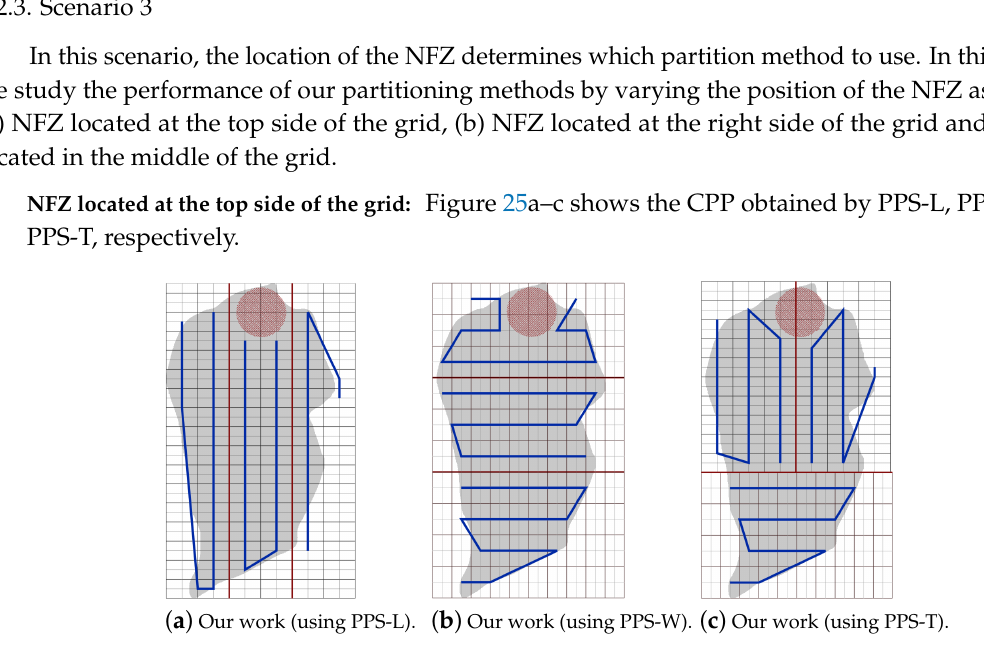
Figure 25. The paths generated by the algorithm by our algorithm using PPS-L, PPS-W and PPS-T with NFZ located at the top of the